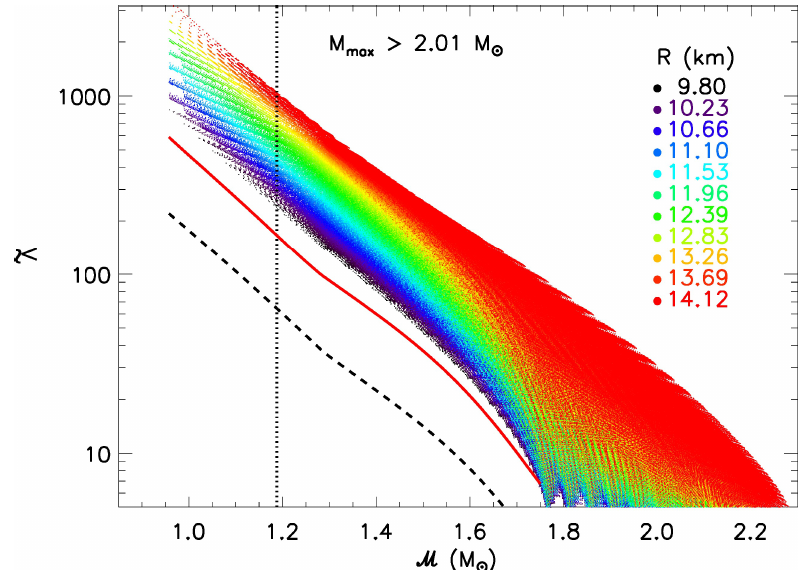
Figure 7. The binary deformability ˜ Λ as a function of chirp mass M from piecewise polytropes subject to causality and a M max > 2 M (cid:12) . Vertical dotted lines indicate M = 1.188 M (cid:12) for GW170817, colors indicate values of R 1.4 and component masses are restricted such that they exceed 1 M (cid:12) . The dashed line shows the causal minimum and the solid line shows the minimum from the unitary gas constraint